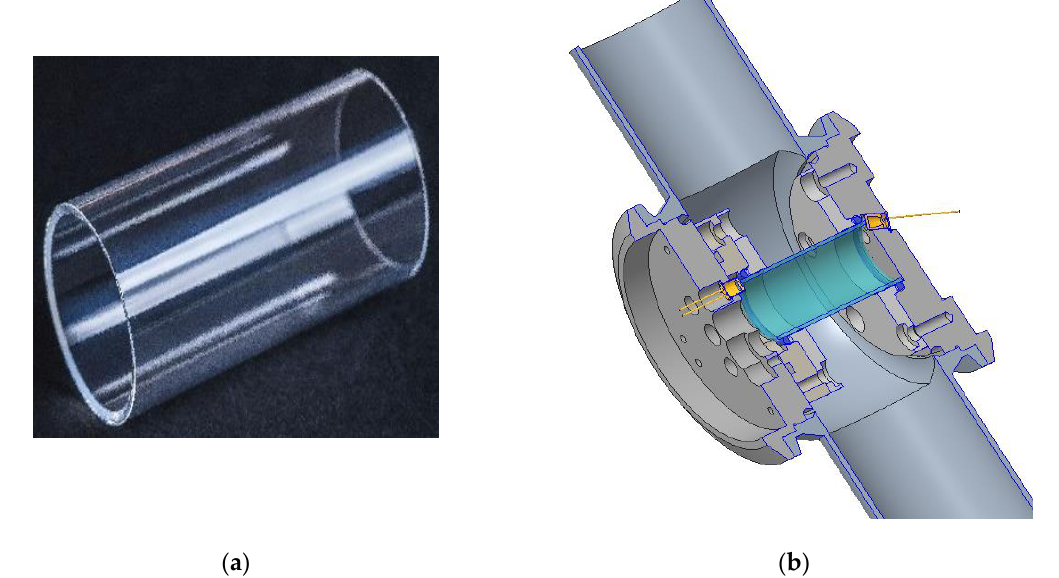
Figure 6. ( a ) Sapphire tube with the 69° wedge on one side. ( b ) Schematic drawing of the mounted ATR element in a flow tube setup with one inclined IR emitter at the right side and one IR detector at the left side of the tube for the ATR transmission experiment.